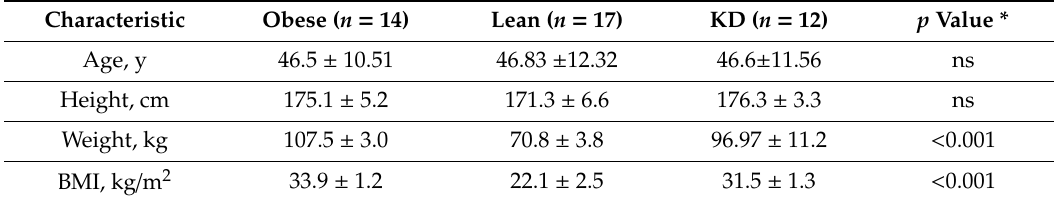
Table 1. Subject characteristics.